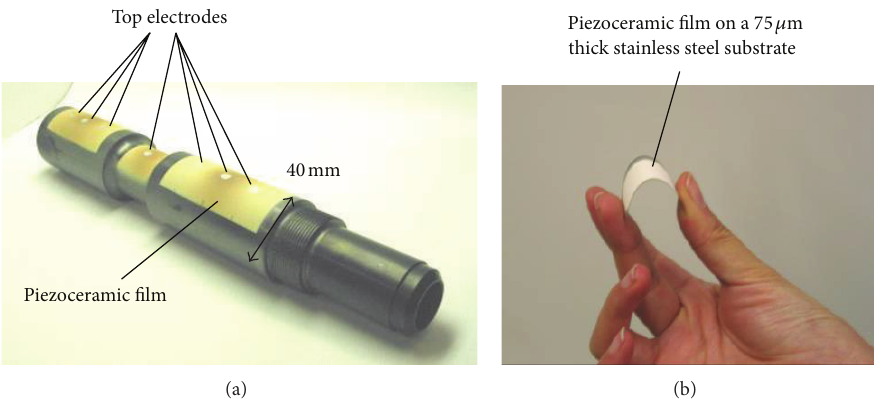
Figure 7: Examples of spray-on piezoelectric acoustic transducers: (a) IUTs and (b) an FUT.